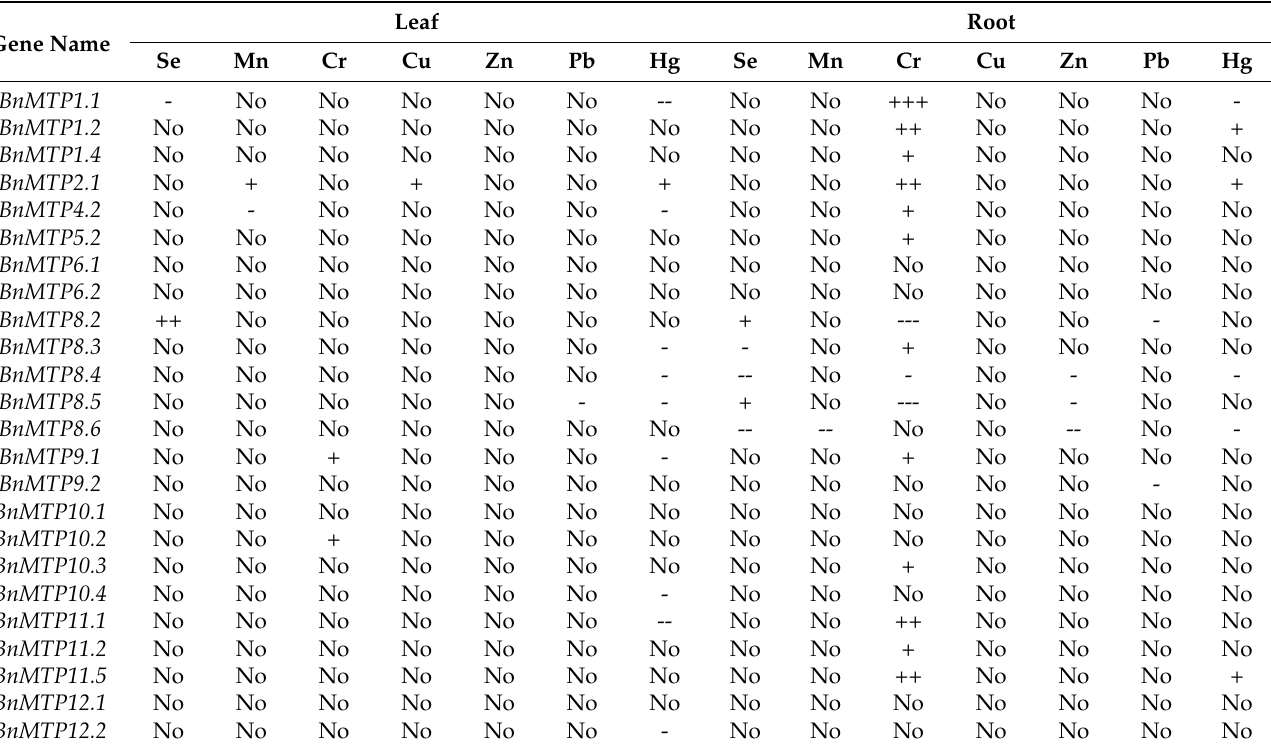
Table 2. Overview of BnMTP gene expression in response to different heavy metal and selenate